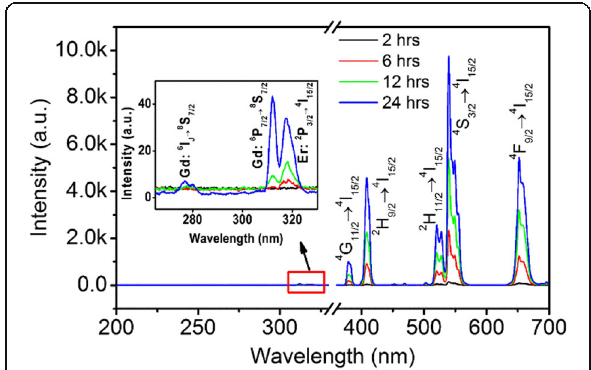
Fig. 7 UC luminescence spectra of the as-prepared heterogeneous core/shell α -NaGdF 4 / β -NaYF 4 :Yb,Er crystals with varied reaction time (black: 2 h, red: 6 h, green: 12 h, blue: 24 h) excited by 980-nm infrared light. (Inset: Local magnified patterns of UC spectra in the region of 265 – 330 nm, in which the characteristic peaks of Gd 3+ were